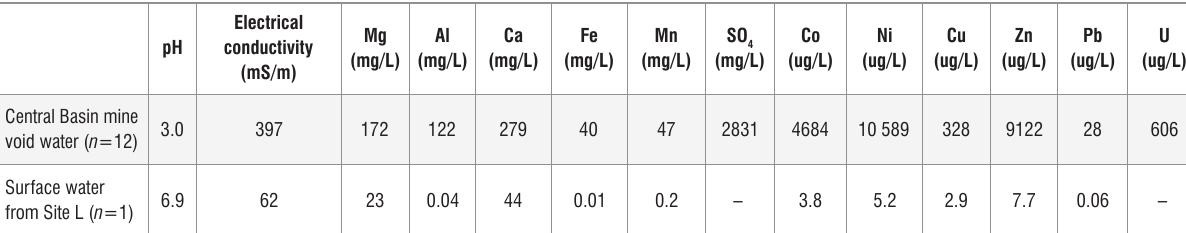
Table 3: Water chemistry from sampling Site L and typical chemical composition of mine void water (50th percentile) from the Central Witwatersrand Basin 24